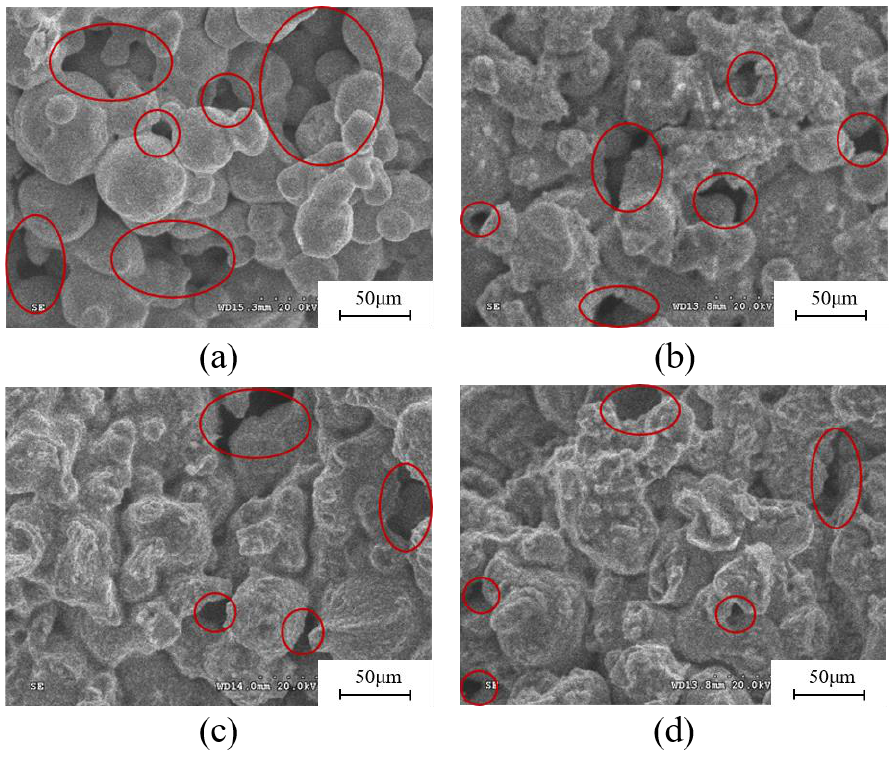
Figure 4. Microscopic photos of sintered body under different sintering time: ( a ) 10 min, ( b ) 20 min, ( c ) 30 min, ( d ) 60 min. ( c ) 30 min, ( d ) 60